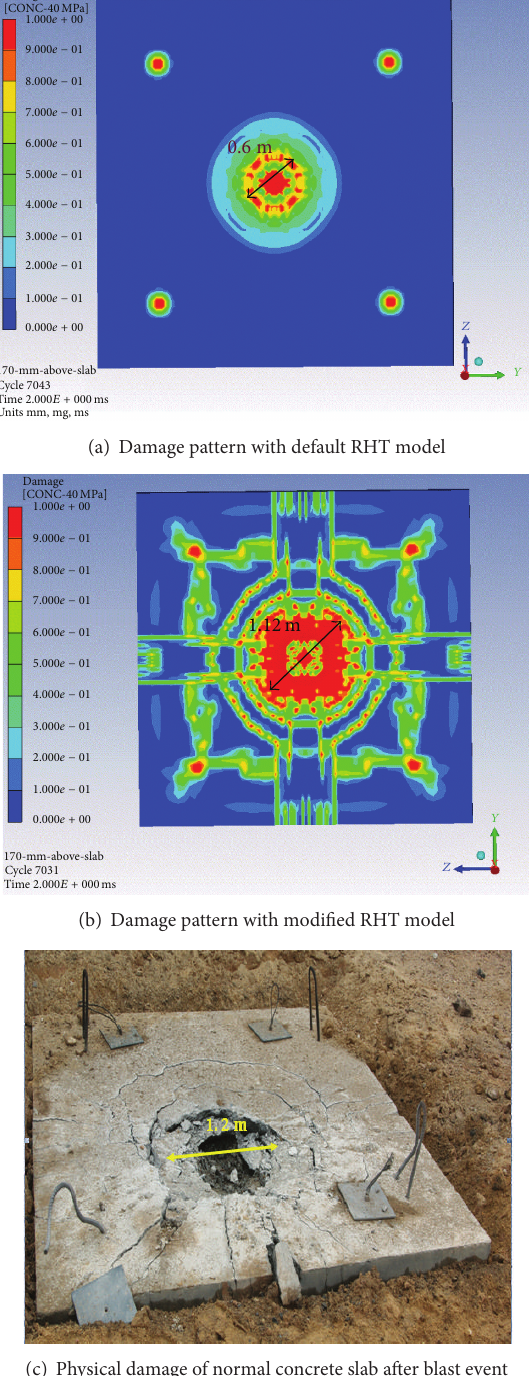
Figure 9: Damaged situations for normal concrete slab after blast